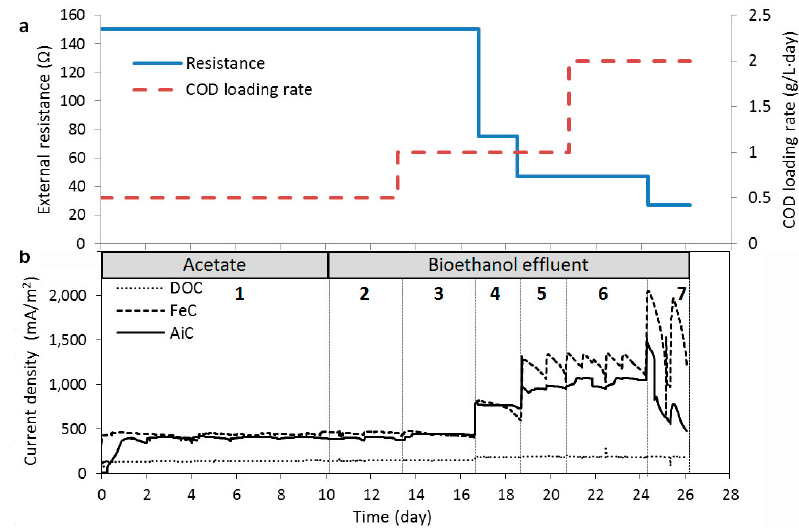
Figure 5. Continuous MFC processes experiment: ( a ) external resistance (——–, left Y -axis) and chemical oxygen demand load (- - - -, right axis) applied during the 7 periods for the total 26 days of experiment; ( b ) current density responses recorded for the MFCs with different cathode types: DOC, FeC and AiC, during the 26 days of experiment.